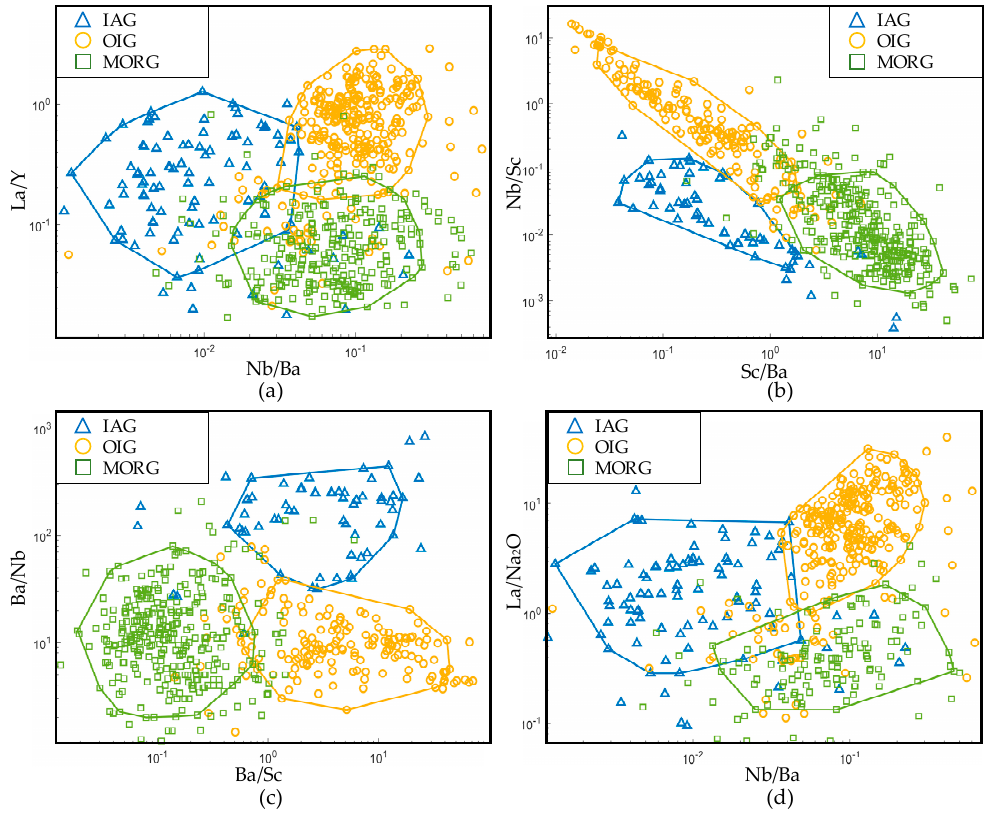
Figure 24. Recommended discrimination diagrams for gabbroic rocks. All four diagrams have 0.85 confidence regions. ( a ) Nb/Ba–La/Y diagram; ( b ) Sc/Ba–Nb/Sc diagram; ( c ) Ba/Sc–Ba/Nb diagram; ( d ) Nb/Ba–La/Na 2 O